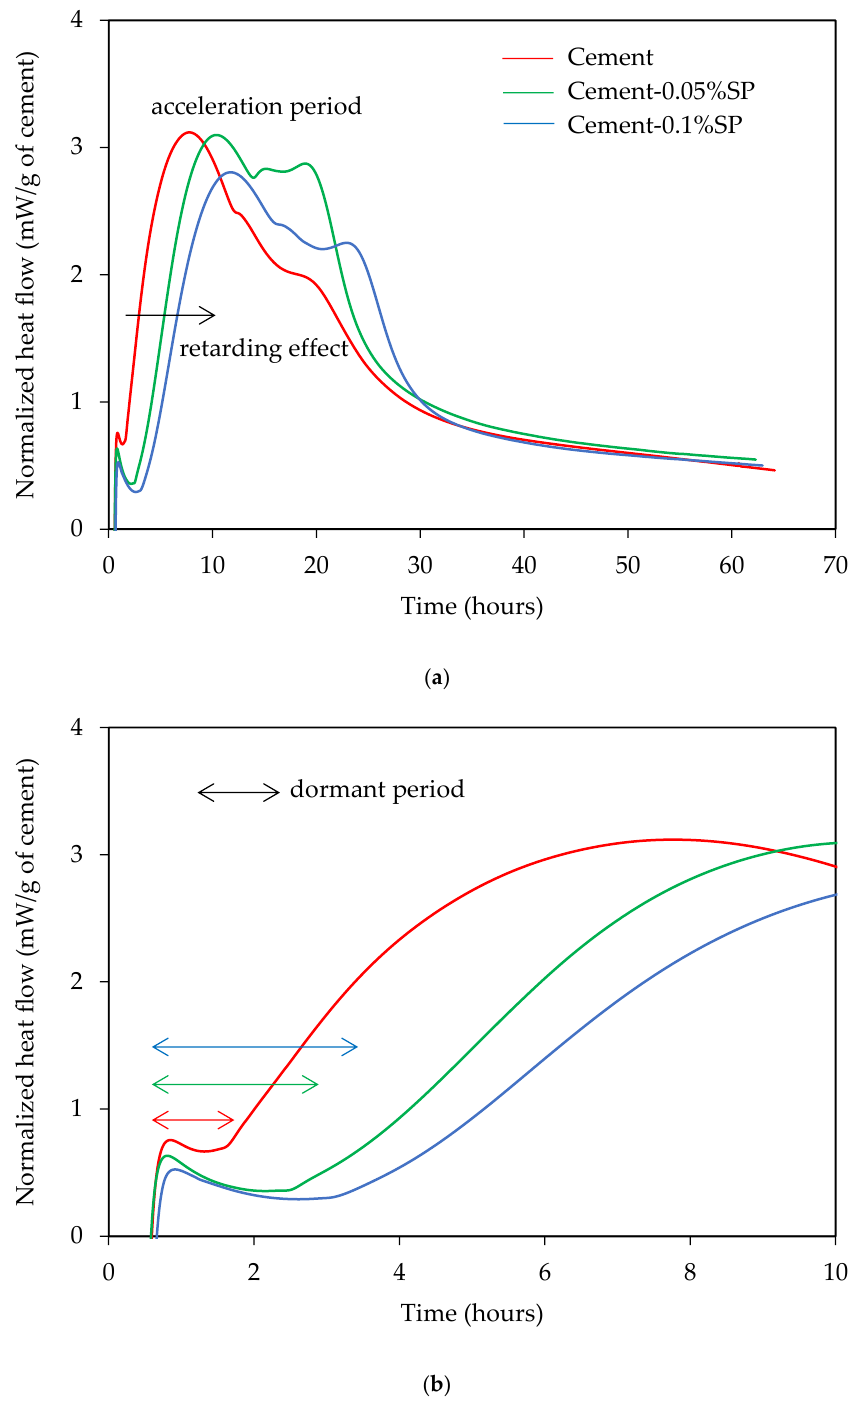
Figure 6. Evolution of the heat flow due to cement hydration. ( a ) retarding effect on the main peak; ( b ) retarding effect on the dormant period